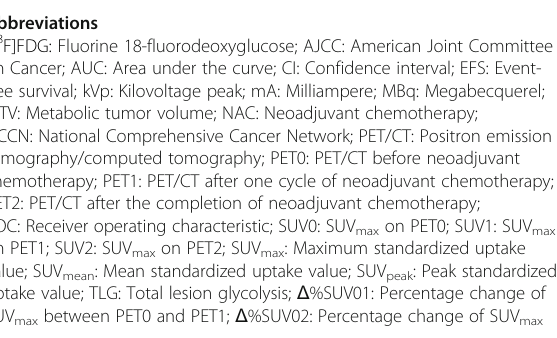
Additional file 1: Table S1 . Summary of Previous